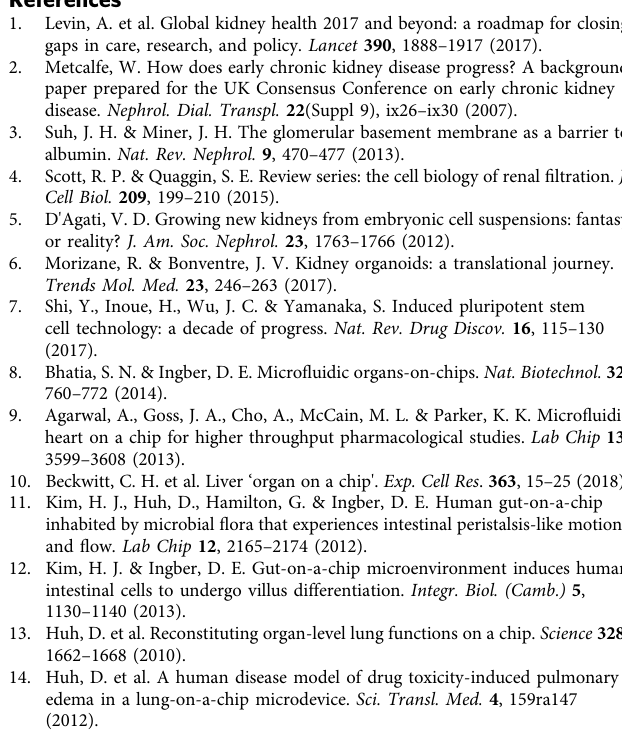
Table 1. FBS-free endothelial cell medium supplemented with 0.5% human serum from diseased and healthy individuals was added to the top inlet and outlet and was incubated for 24 h. After 24 h, the human serum-supplemented media was removed from the chips and the albumin assay was performed as described above. Healthy patient serum was used as a